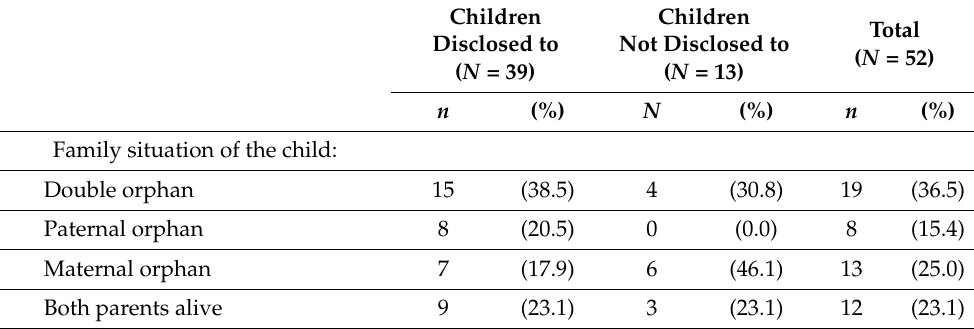
Table 1. Family situation of the study children failing first-line ART.